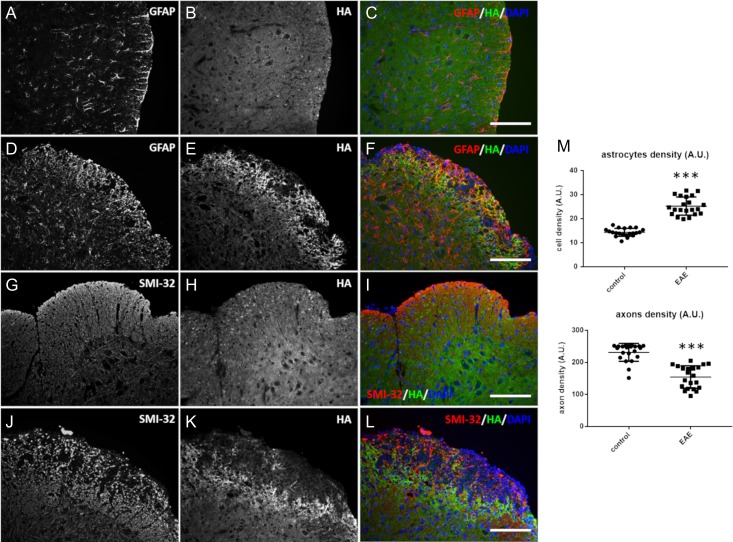
Axonal loss but not astrocytosis followed the pattern of hyaluronan (HA) degradation present in the tissue lesion. Transverse sections of the spinal cord of control (A–C, G–I) and experimental autoimmune encephalomyelitis (EAE) (D–F, J–L) mice were costained for astrocytes (GFAP) (A, D) or axons (SMI-32) (G, J) and HA (B, E, H, K). (C) and (F) are the merged micrographs that display HA (green), GFAP (red) and the DAPI counterstain (blue). (I) and (L) are the merged micrographs that display HA (green), SMI-32 (red) and the DAPI counterstain (blue). An evident astrocytosis (elevated GFAP staining) is observed in the white matter of EAE mice (scale bar, 80 μm). (M) shows the quantification of astrocytes and axons in the white columns of spinal cord tissue sections (seven tissue sections were evaluated for each control and EAE group. The mean along with the positive and negative standard deviations are represented. Three random fields of view for each tissue section were ascertained. ***P < 0.001, t test compared with respective controls).